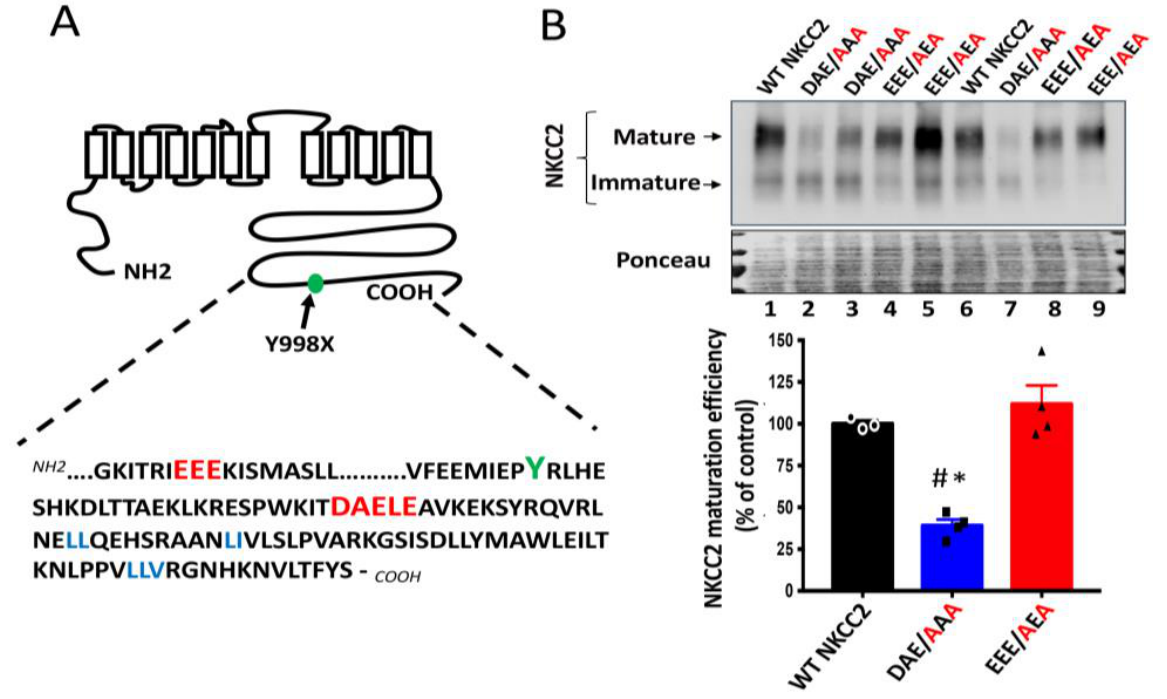
Figure 2. Comparison between the roles of 949 EEE 951 and 1019 DAE 1023 motifs in NKCC2 processing. ( A ) The distal region of NKCC2 C-terminal tail harbors two consensus di-acidic (D/E-X-D/E) motifs (red), 949 EEE 951 and 1019 DAELE 1023 , located upstream and downstream from Y 998 residue (green), respectively. ( B ) Immunoblot analysis of OKP cells transiently transfected with wild-type or mutated NKCC2 proteins that were generated by mutating the 1019 DAE 1023 motif to AAA (DAE/AAA) or mutating the 949 EEE 951 motif to AEA (EEE/AEA). Forty-eight hours post-transfection, total cell lysates were separated by SDS-PAGE and Myc-tagged NKCC2 proteins were revealed by anti-Myc antibodies. Lower panel, Densitometric analysis of the maturation efficiency of WT NKCC2 or mutant proteins, estimated as the ratio of the mature vs. immature form of the cotransporter. Data are expressed as percentage of control (WT NKCC2) ± S.E. WT NKCC2, n = 3. DAE/AAA, n =4. EEE/AEA, n =4. # p < 0.002 versus WT NKCC2. * p < 0.0004 vs. EEE/AEA.